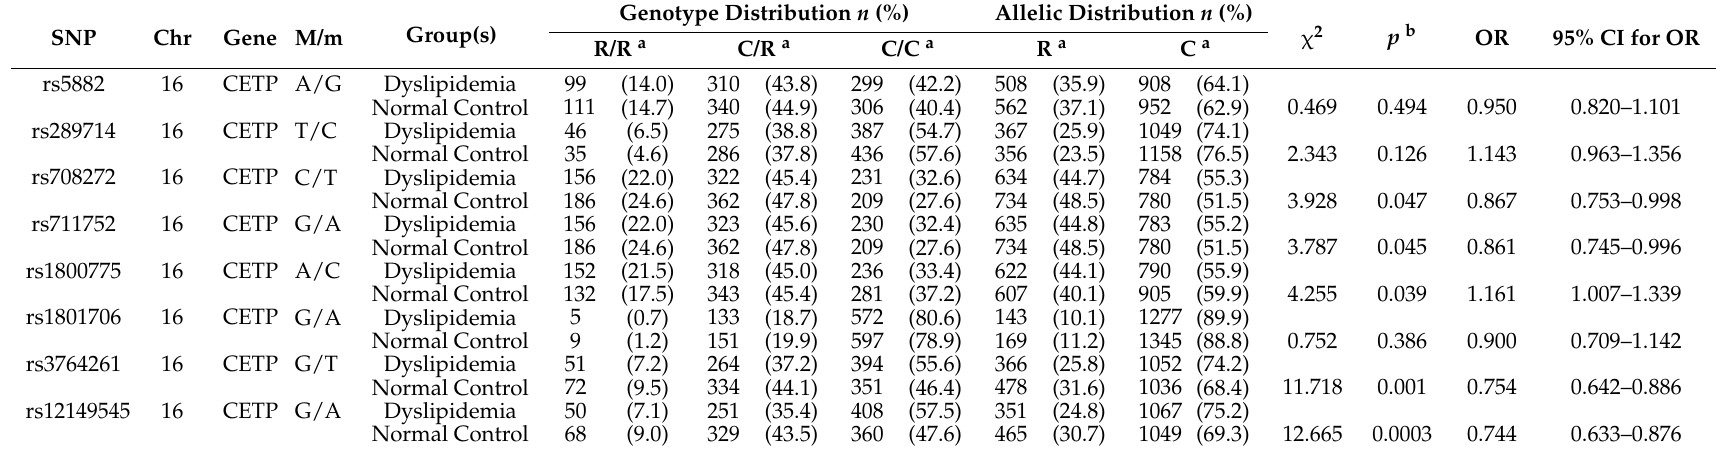
Table 2. Association of CETP SNPs in Dyslipidemia and Normal Control individuals in Xinjiang national minority.